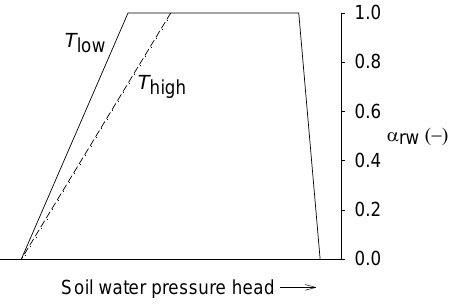
Fig. 2. Reduction coefficient for root water uptake, α rw , a function Figure 2. Reduction coefficient for root water uptake, α of soil water pressure head and potential transpiration rate T p (after head and potential transpiration rate T Feddes et al.,